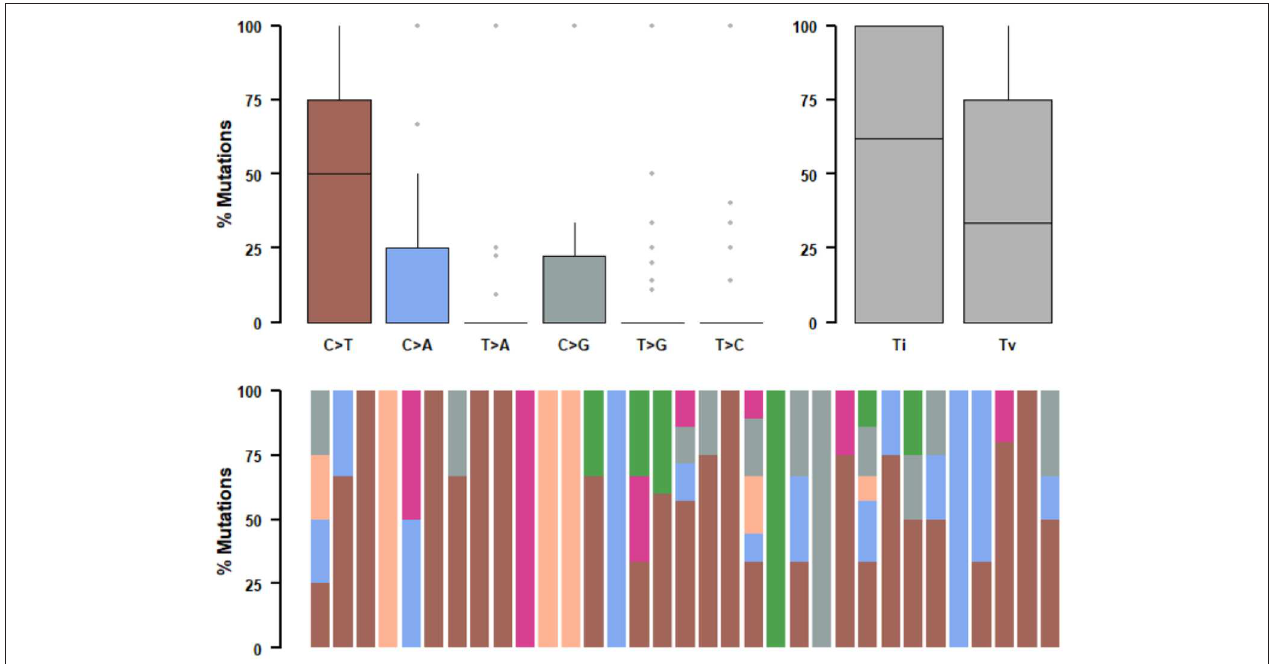
FIGURE 4 | Mutational signatures of ALK fusion positive NSCLC patients. SNPs are classified into transitions and transversions. Summarized data are visualized as a boxplot showing overall distribution of six different conversions (Top) and as a stacked barplot showing the fraction of conversions in each sample (Bottom) .